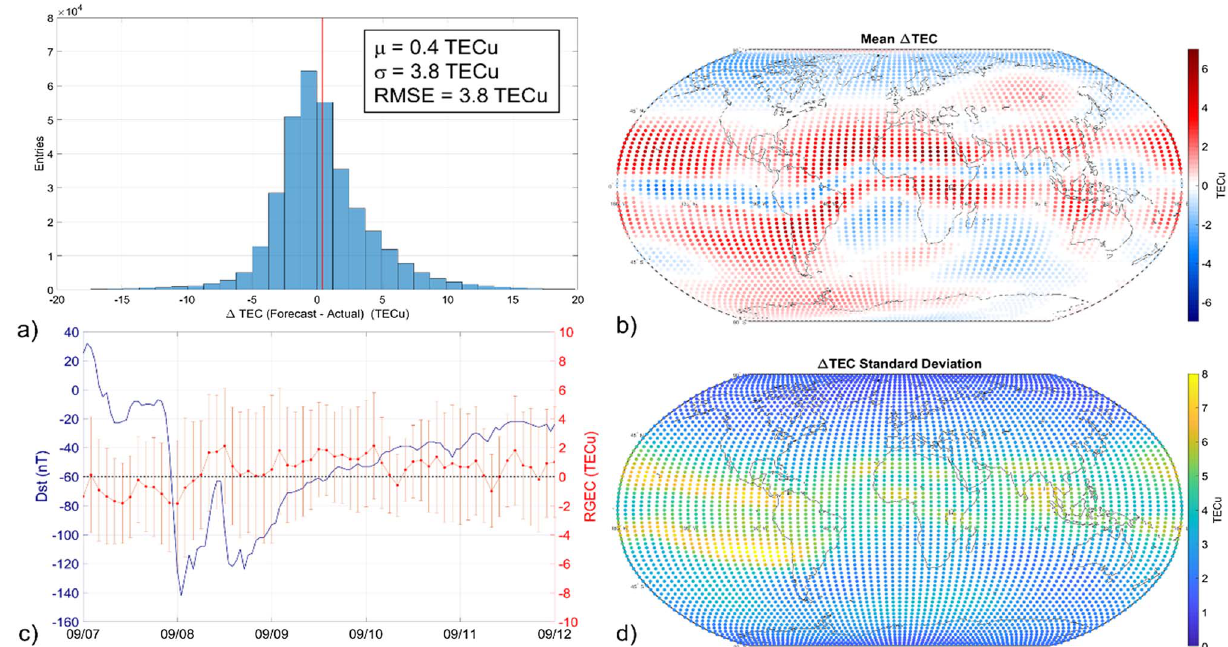
Fig. 10. Example of model performance against Final Global TEC product provided by the Universitat Politècnica de Catalunya (UPC) for the period 7 – 11 September 2017: (a) distribution of TEC difference (forecast-actual), statistical parameters are reported together with a red line indicating the mean; (b) map of the mean values of the TEC difference (forecast-actual); (c) time pro fi le of the RGEC parameter (right y axis) and Dst (left y axis), the black dashed line indicates the zero reference value; (d) map of the standard deviation of the TEC difference (forecast- actual).